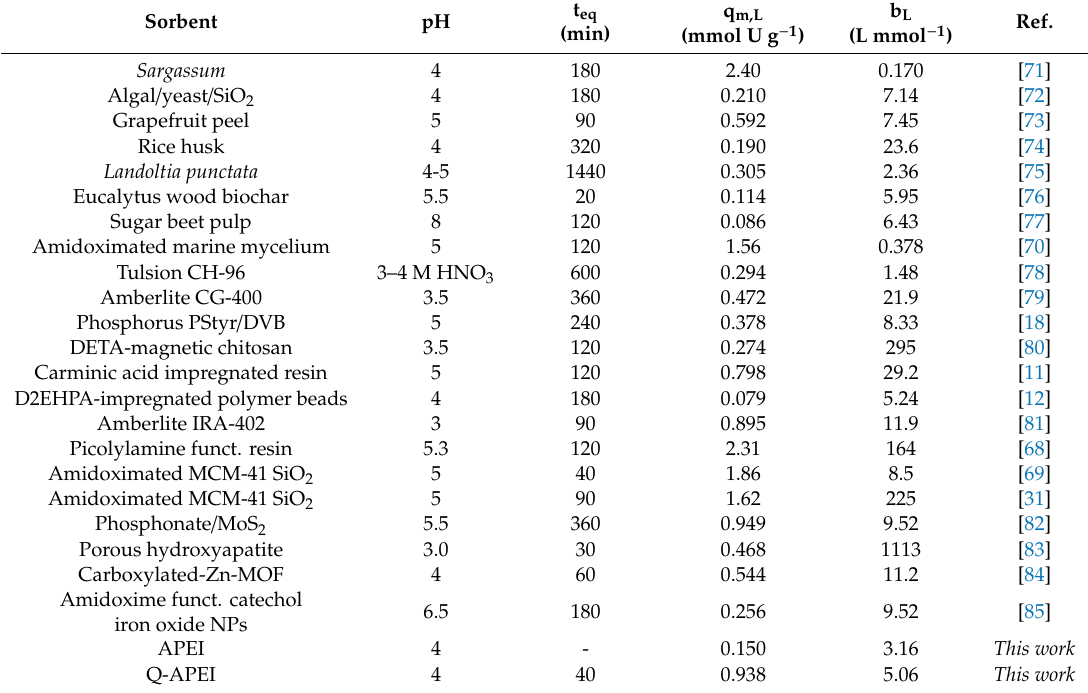
Table 3. Comparison of sorbents for U(VI) recovery in acidic solutions (sorption performances: optimum pH, equilibrium time, and Langmuir